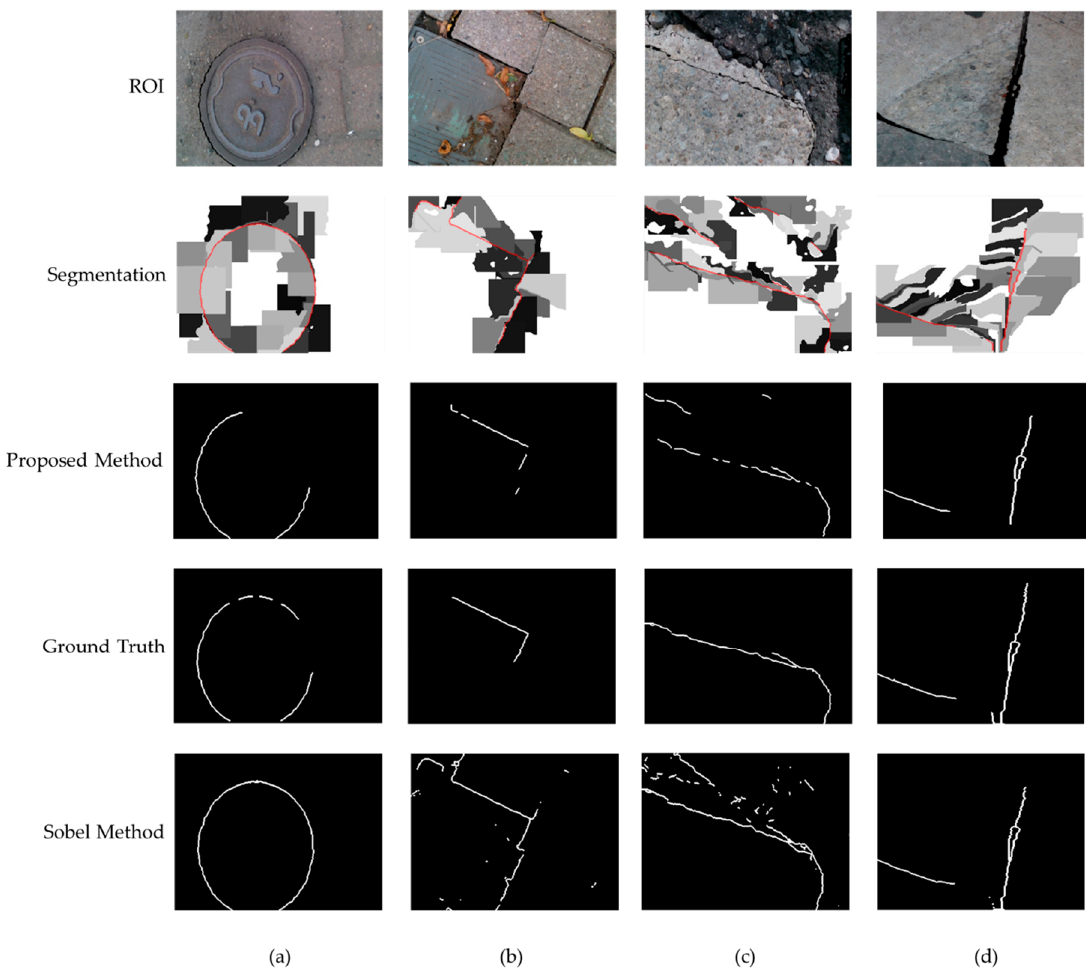
Figure 9. ( a – d ) are examples of crack detection algorithm performed on tripping hazards found in the sidewalk where the first row shows the ROI images, the second row shows the images after segmentation with the crack outlined in red, the third row shows the final results of our proposed edge detection algorithm, the fourth row is the ground truth images, and the fifth row shows the output of the conventional Sobel algorithm.